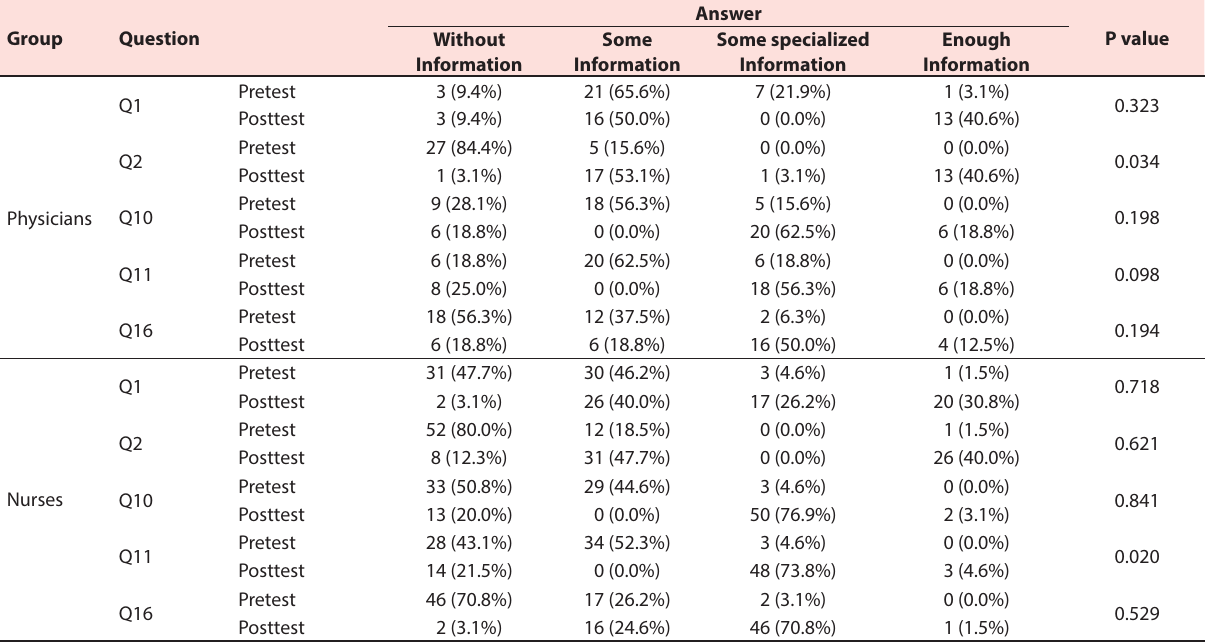
Table 1. Evaluation of medical personnel’s knowledge about nuclear events before and after training Group Question